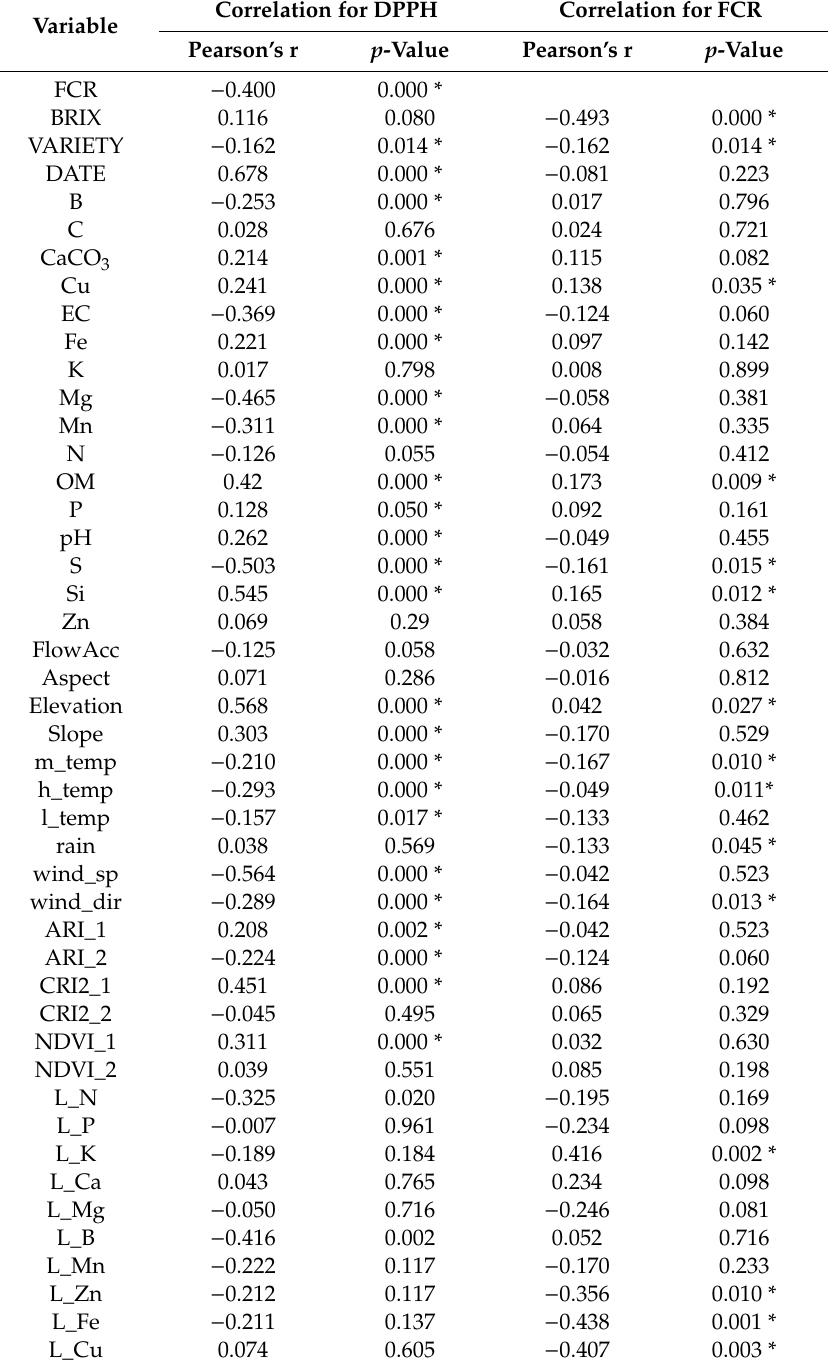
Table 4. Pearson’s r correlation between soil, remote sensing and climatic attributes with DPPH and